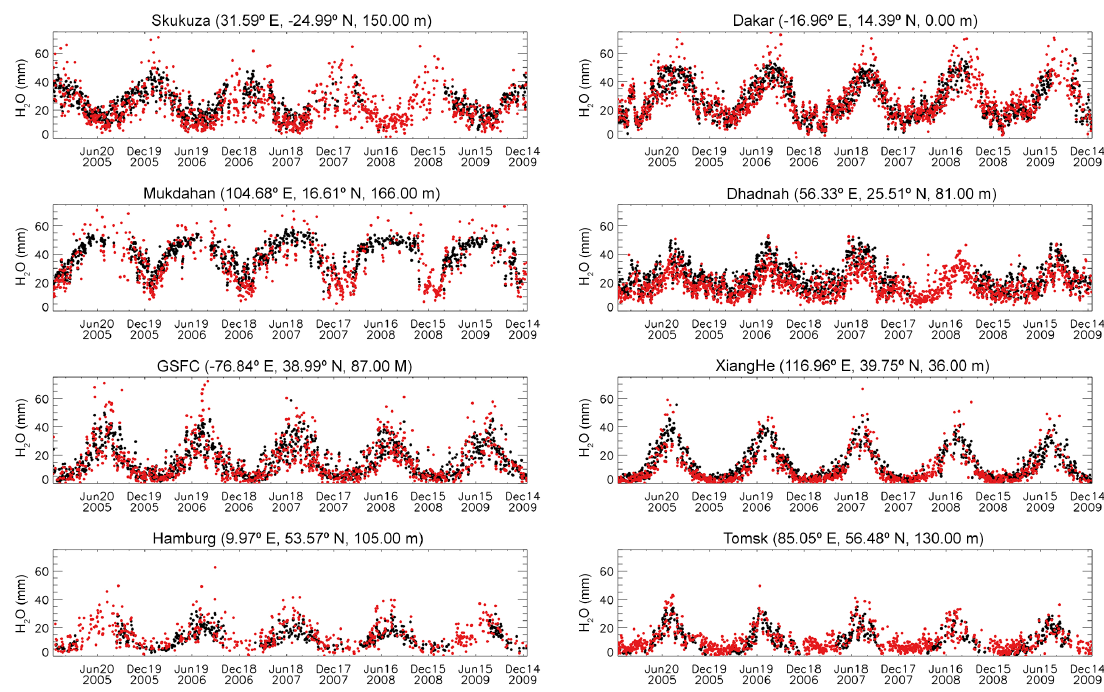
Figure 5. Time series comparison between version 1.0 OMI (red) and AERONET (black) at selected AERONET stations from 1 January 2005 to 31 December